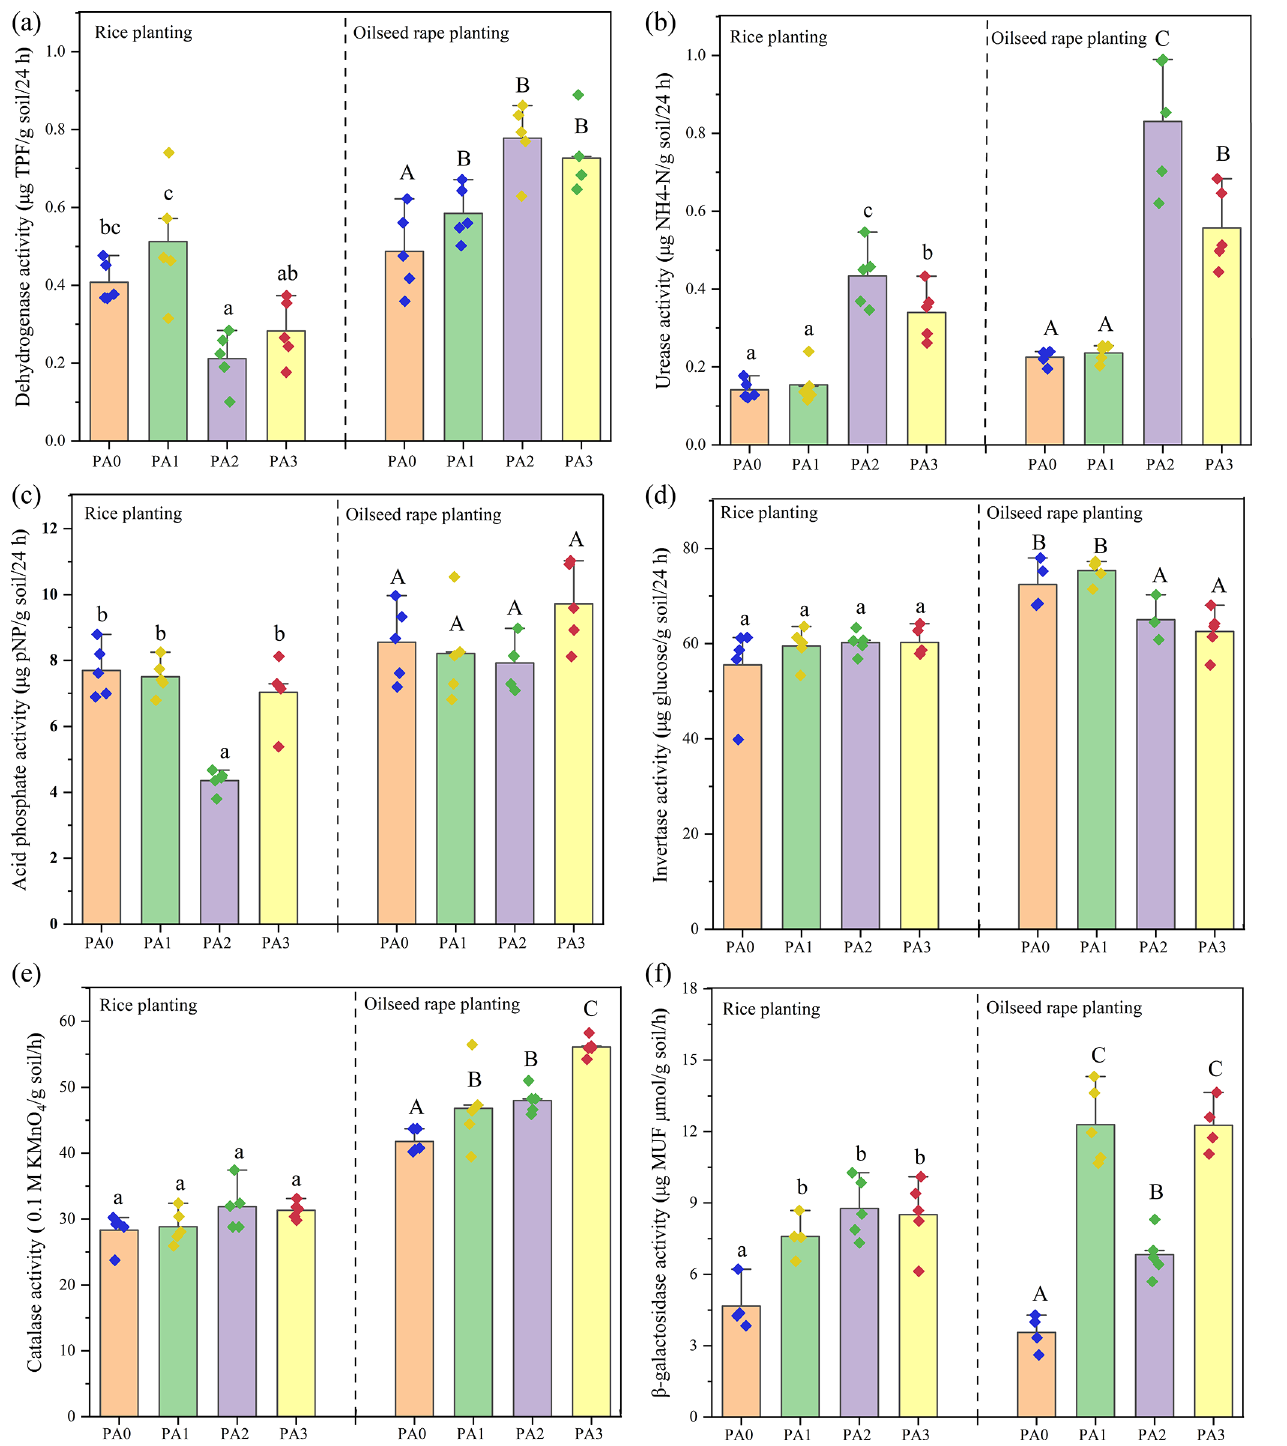
Figure 6. The effects of different amendments on the activities of soil enzymes. Dots represent the value of each sample. Bars followed with different lowercase letters (a–c) and capital letters (A–C) indicate the significant ( p ≤ 0 . 05) difference among different treatments in rice planting and oilseed rape planting according to the LSD test. Values represent means ± standard